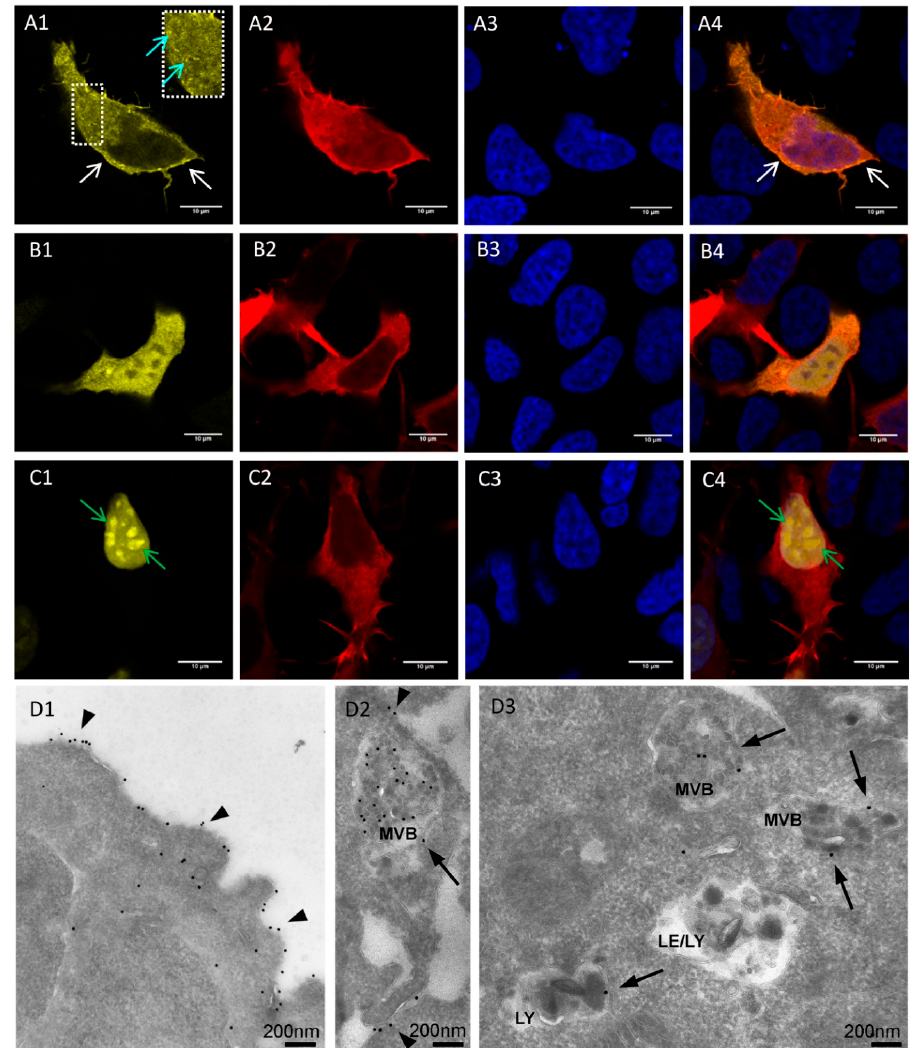
Figure 2. Light and electron microscopic localization of mV-opto-FGFR1s in human embryonic kidney (HEK293) cells. ( A – C ) Immunofluorescence microscopy of cells co-transfected with mV-opto-FGFR1s and LifeAct – mCherry to visualize cell bodies and all cytoplasmic processes. ( A1 ) mV-mem-opto-FGFR1 is observed in the plasma membrane (white arrows) and in endosomes (inset; cyan arrows) indicating endosomal receptor internalization. ( B1 ) mV-cyto-opto-FGFR1-transfected cells reveal diffuse yellow fluorescence in the cytoplasm and nucleus of transfected cells. ( C1 ) mV-nucl-opto-FGFR1 is only located in the nucleus (nuclear speckle domains are indicated by green arrows). Fixed cell nuclei are stained with Hoechst (blue) and A4 – C4 represent overlays. Scale bars for all images are 10 μ m. ( D ) Immunogold electron microscopy of the thawed cryosections reveals mV-mem-opto-FGFR1 in the plasma membrane (arrowheads in D1 and D2 ) and in the limiting membrane as well as inside various endocytic compartments (arrows in D2 and D3 ); MVB = multivesicular body, LE = late endosome, LY = lysosome.